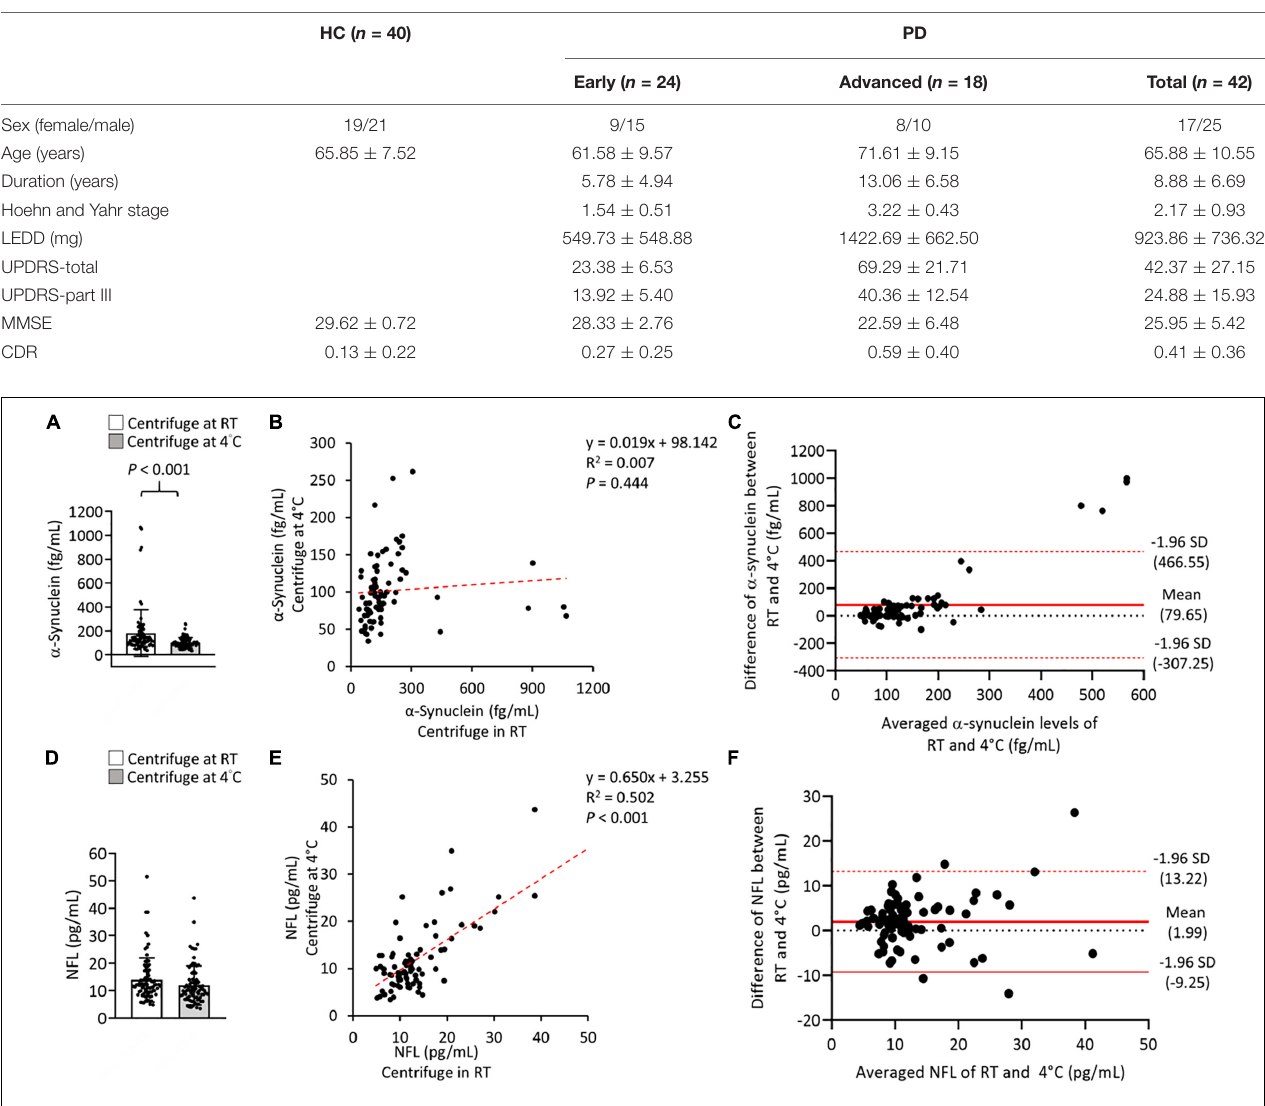
FIGURE 3 | Levels of α -synuclein and NFL in the plasma were centrifuged at different temperatures. (A) Plasma levels and α -synuclein in K 2 -EDTA tubes were centrifuged at room temperature (RT) or 4 ◦ C. (B) Correlations between α -synuclein levels in K 2 -EDTA tubes centrifuged at RT or 4 ◦ C. (C) Bland-Altman plot of the comparability of α -synuclein levels in K 2 -EDTA tubes centrifuged at RT or 4 ◦ C. The red dotted lines represent limits of agreement (mean difference ± 1.96 SD ). (D) Plasma levels and of NFL in K 2 -EDTA tubes centrifuged at RT or 4 ◦ C. (E) Correlations between NFL levels in K 2 -EDTA tubes centrifuged at RT or 4 ◦